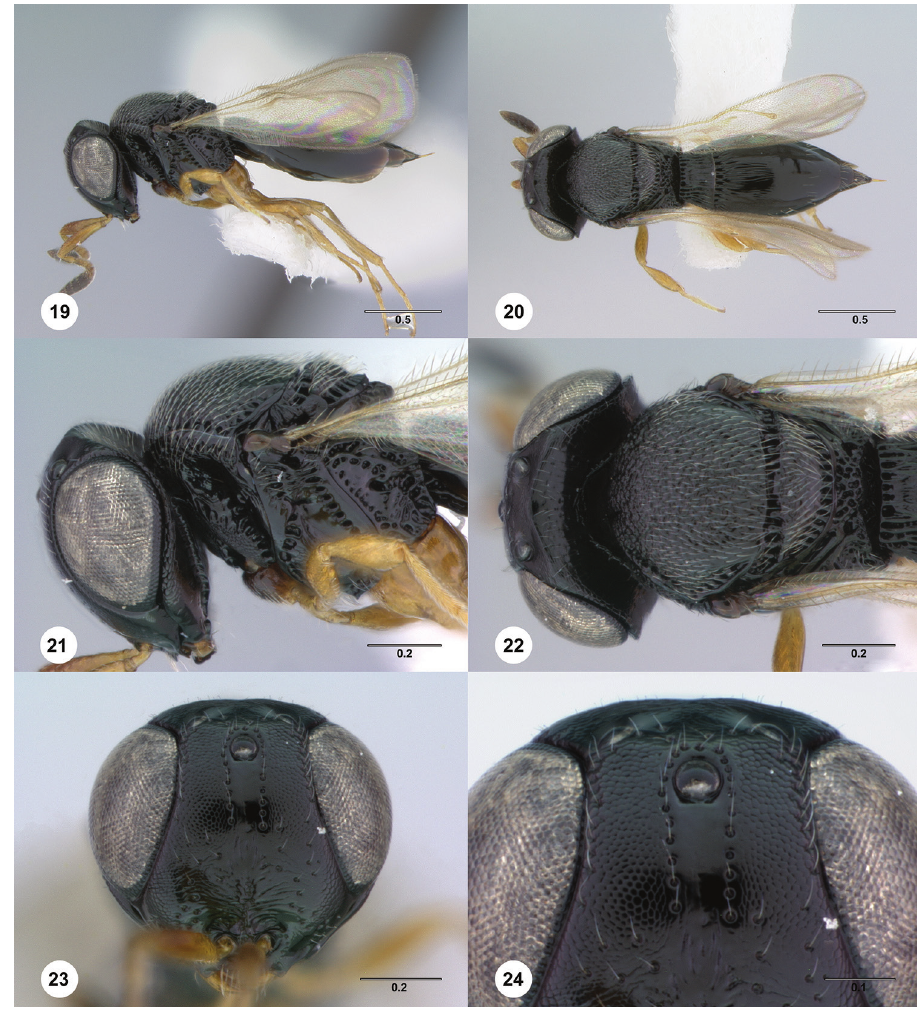
21 Head, mesosoma, lateral view 22 Head, mesosoma, dorsal view 23 Head, mouthparts, anteroventral view 24 Frons, anteroventral view. Scale bar in millimeters. Median keel on frons: absent. Sculpture of lower frons: with multiple transverse rugae; with irregular rugosity. Shape of mandible: slender. Median tooth of mandible: as large as adjacent teeth. Frons below median ocellus: with 2 perfectly parallel rows of setiferous punctures. Sculpture on posterior half of mesoscutum: coriaceous to rugulose, at most with fine irregular longitudinal sculpture. Sculpture of anterior half of mesoscutellum: ru- gose-punctate. Thin median foliaceous lamella on propodeum: absent. Color of coxae: bright yellow, concolorous with